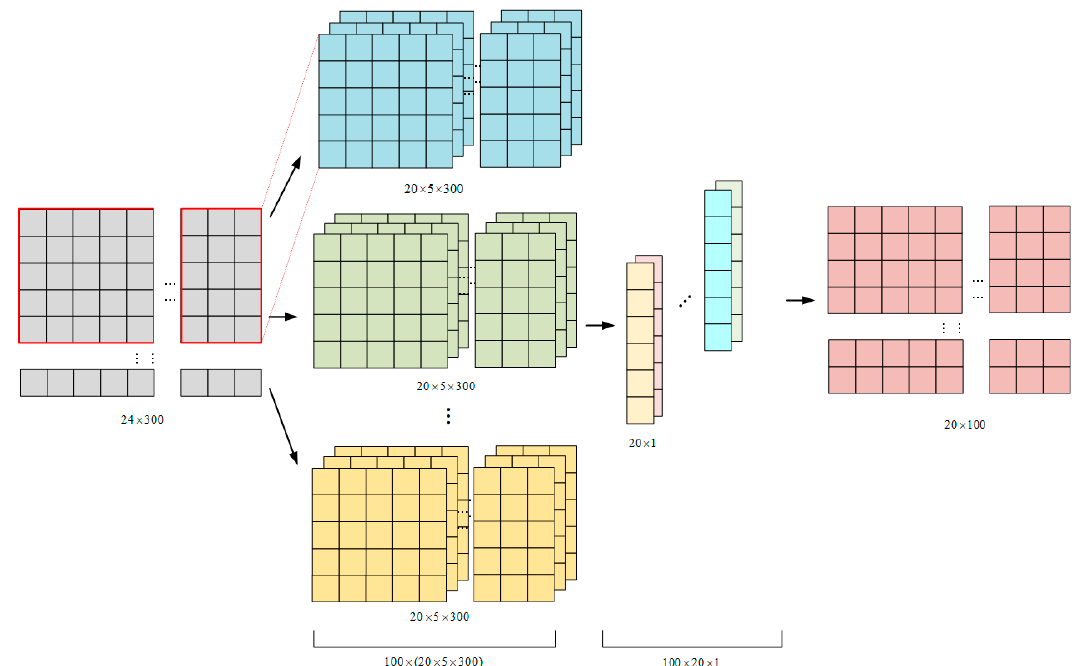
Figure 4. The structure of CNN module.